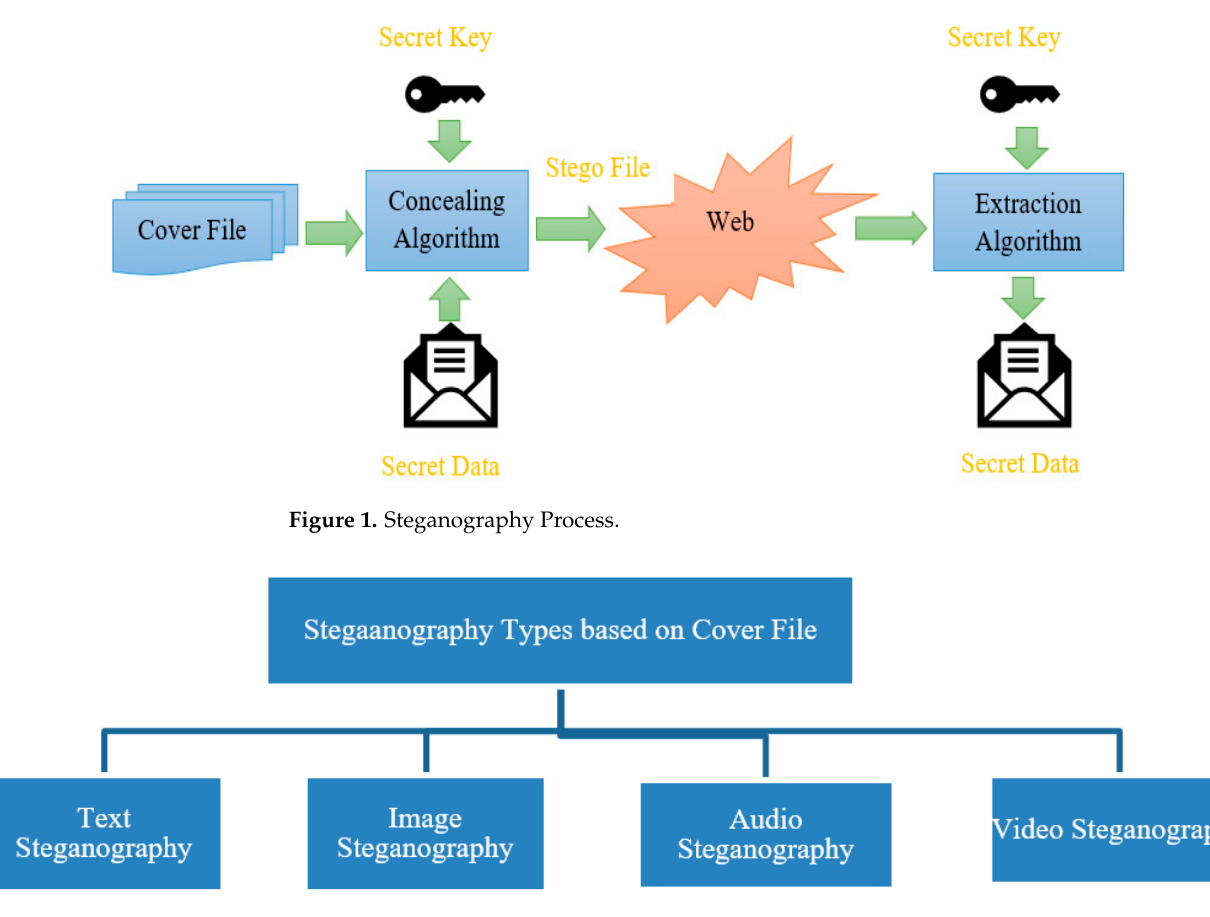
Figure 2. Steganography Types.